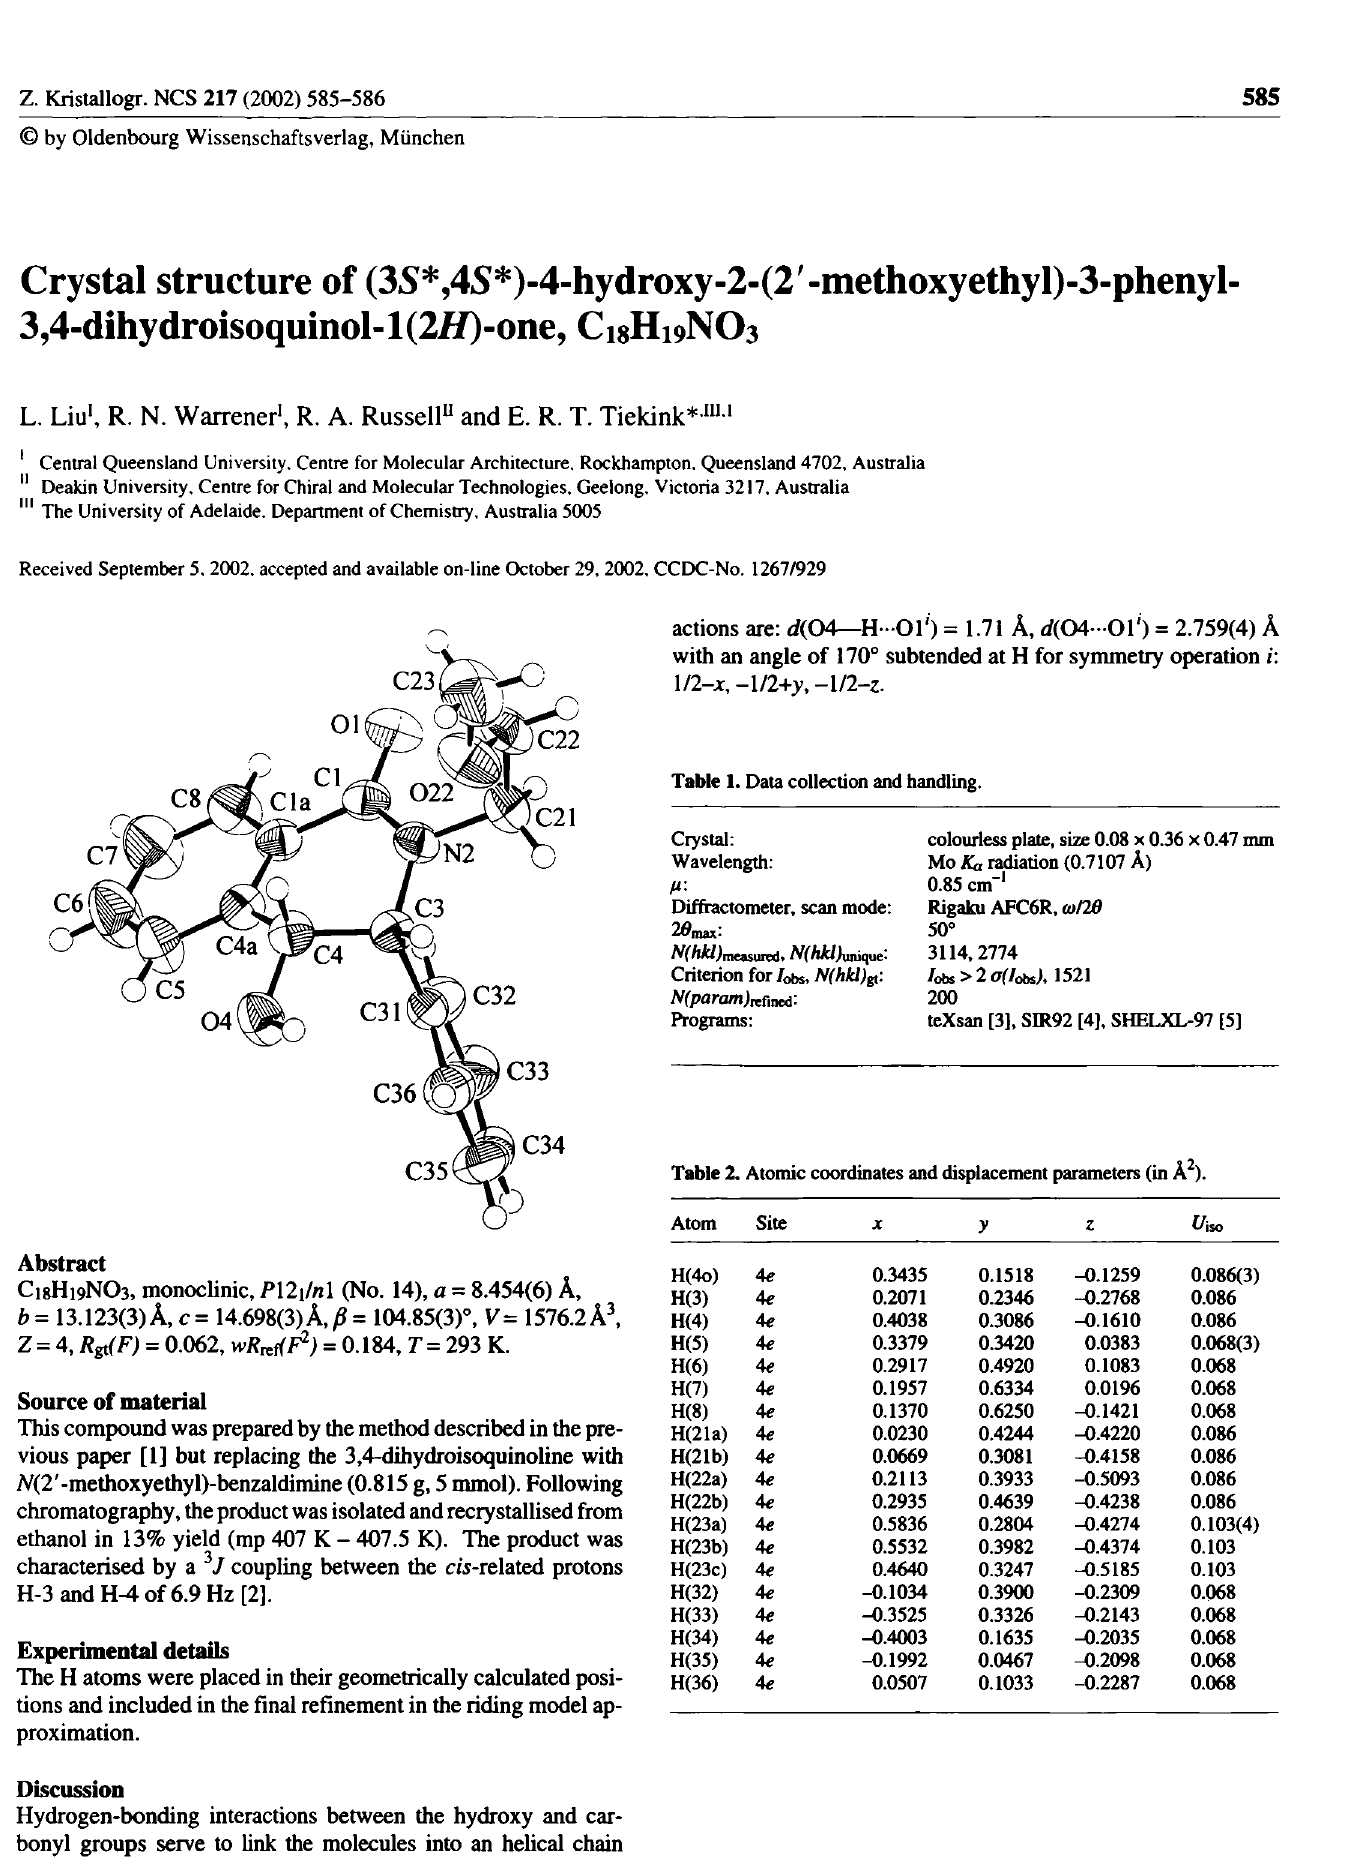
Table 2. Atomic coordinates and displacement parameters (in Â 2